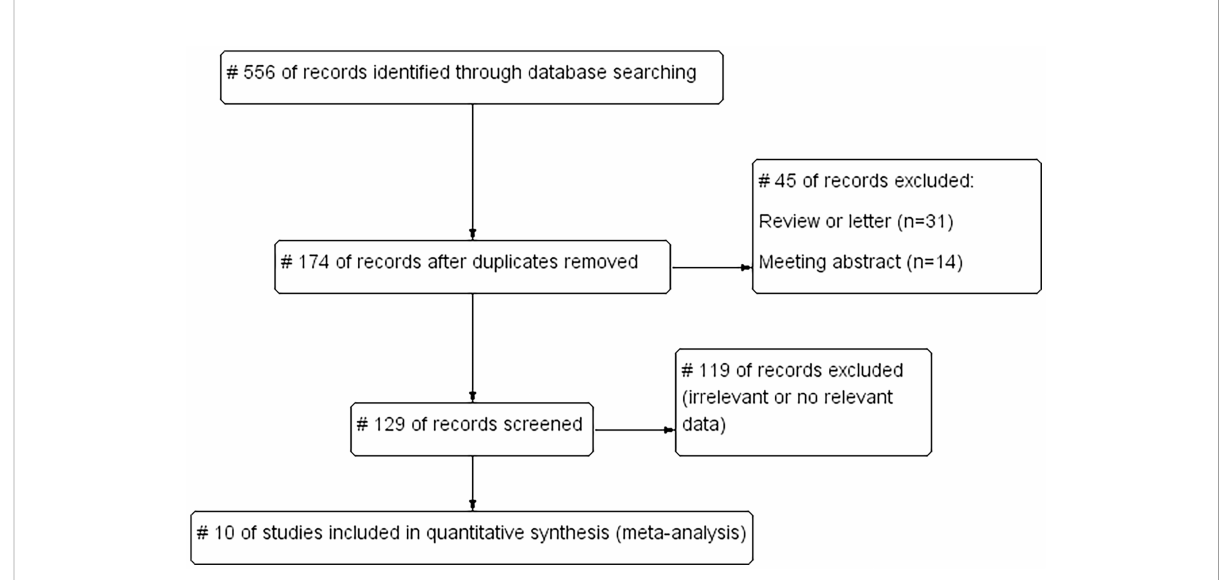
FIGURE 1 Literature screening fl